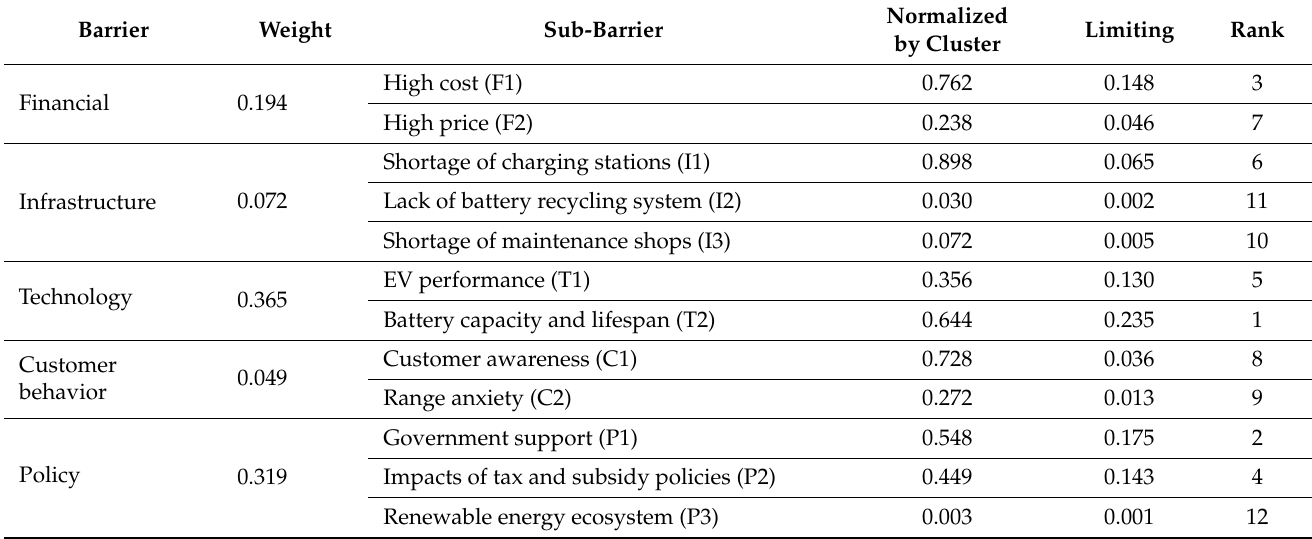
Table 5. Weights of EV